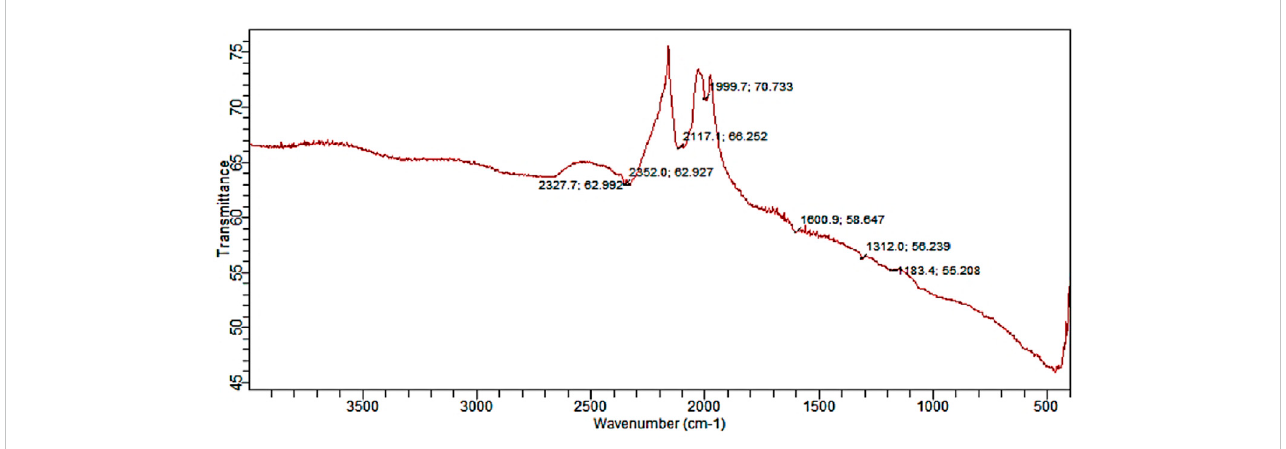
FIGURE 4 FT-IR spectrum indicating important stretching frequencies in SOR-AgNPs.